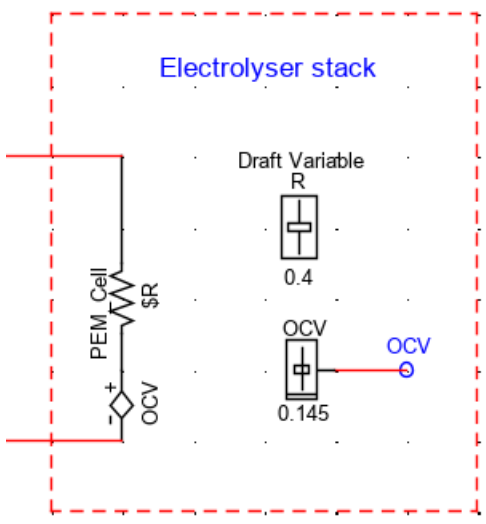
Figure 3. Electrolyser stack model in RSCAD ®